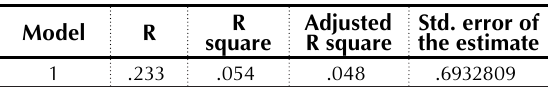
Table 9. Results of the first residual test